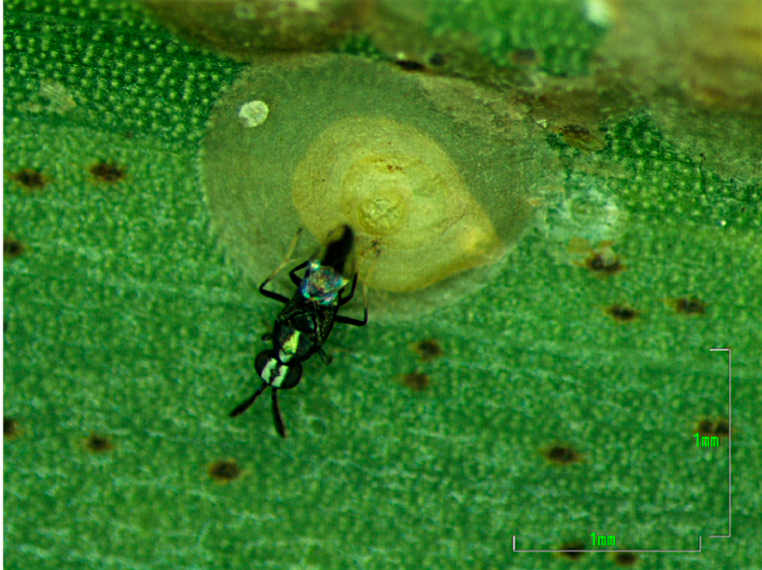
Figure 3. Adult female Comperiella calauanica ovipositing on a third instar female Aspidiotus rigidus nymph.